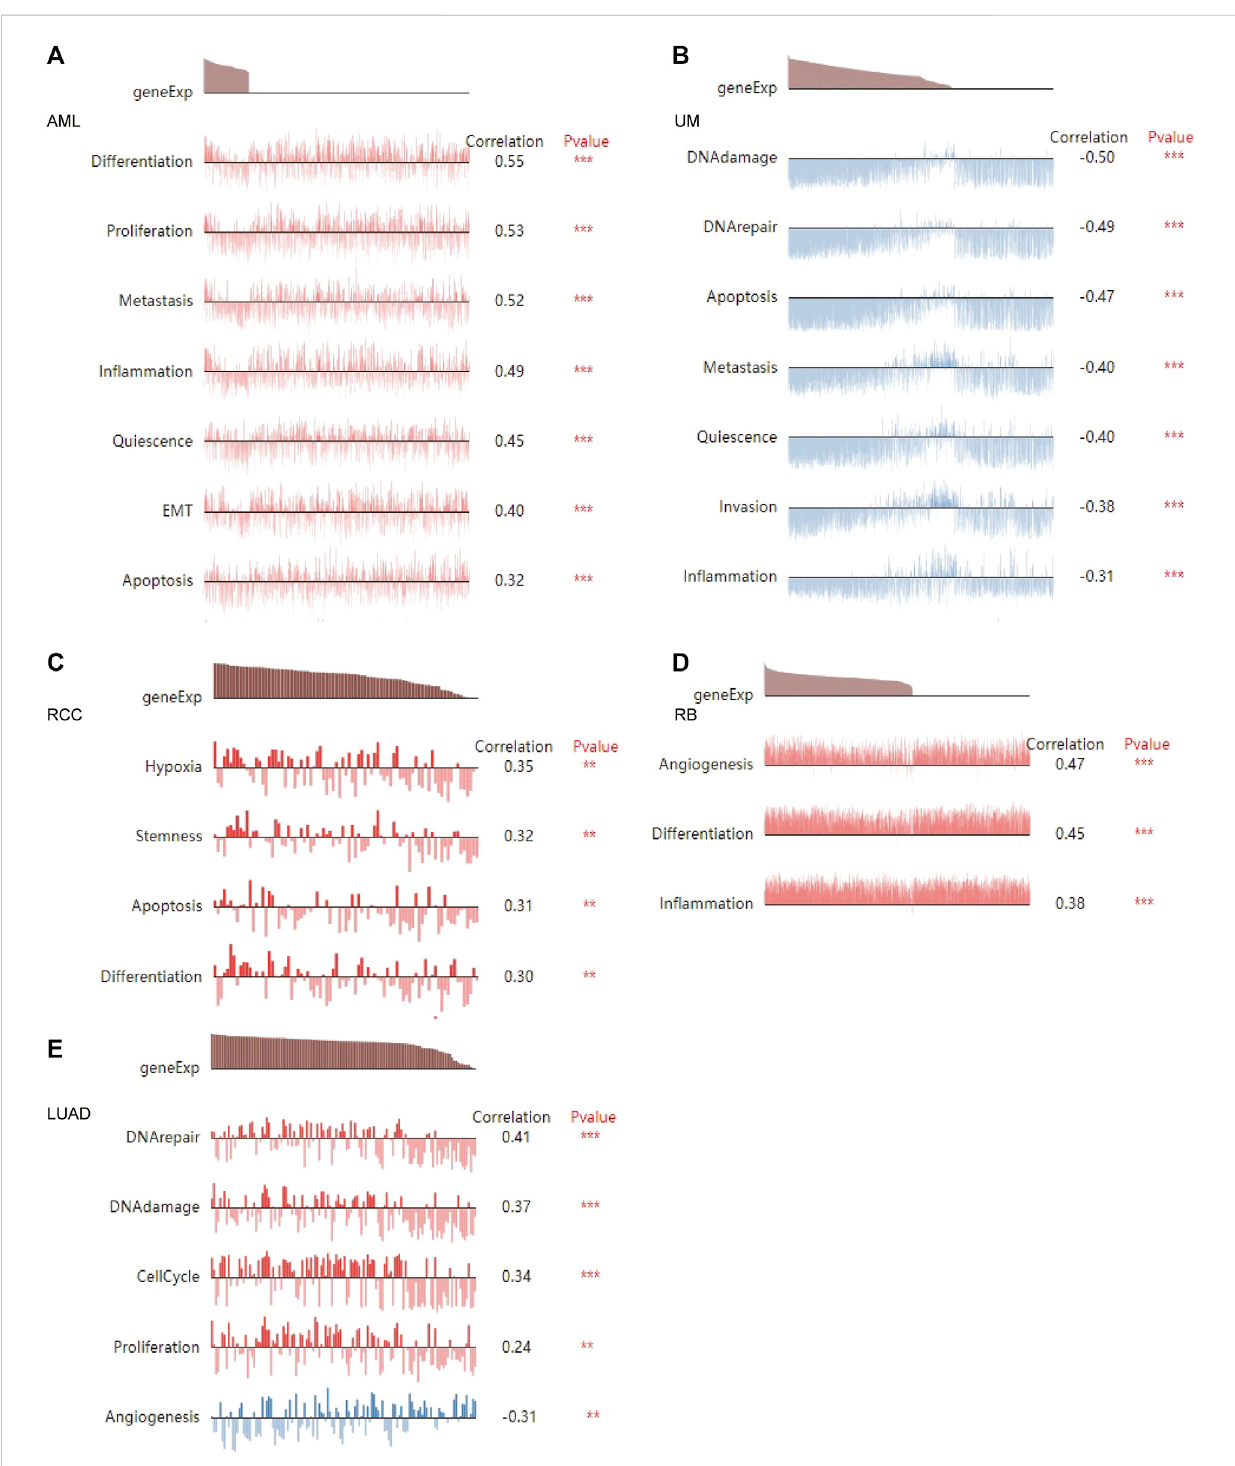
FIGURE 10 The relationship between DLD and tumor biological function in AML (A) , UM (B) , RCC (C) , RB (D) , and LUAD (E) . *** p < 0.001; ** p < 0.01.